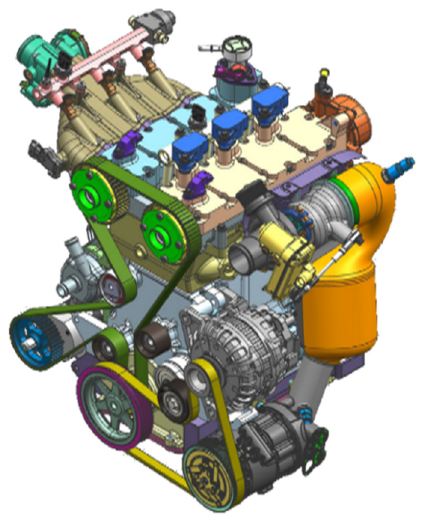
Figure 1. The new prototype engine.